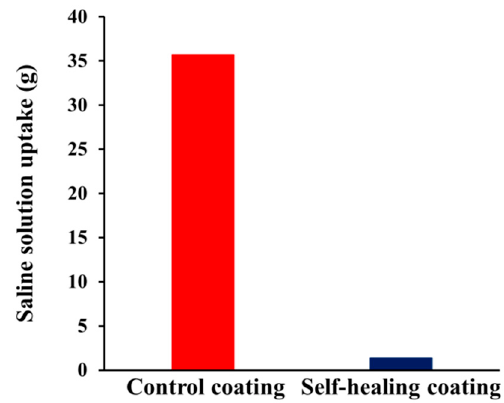
Figure 8. Saline solution permeability test for coated mortar specimens: graph of saline solution uptake of the specimens upon immersion of the scratched surface in a saline solution for 48 h at − 20 °C.